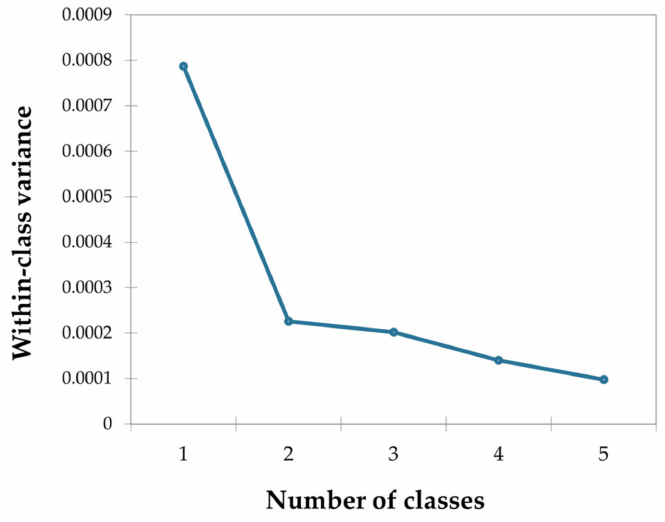
Figure 8. Elbow plot based on the share of enterprises using industrial robots. Source: Author’s Contribution. Data retrieved from Eurostat. Robotics and 3D Printing Data, https://ec.europa. eu/eurostat/databrowser/bookmark/f29db2df-2e19-4bfd-8bb4-af630dc3e907?lang=en, accessed on 15 March